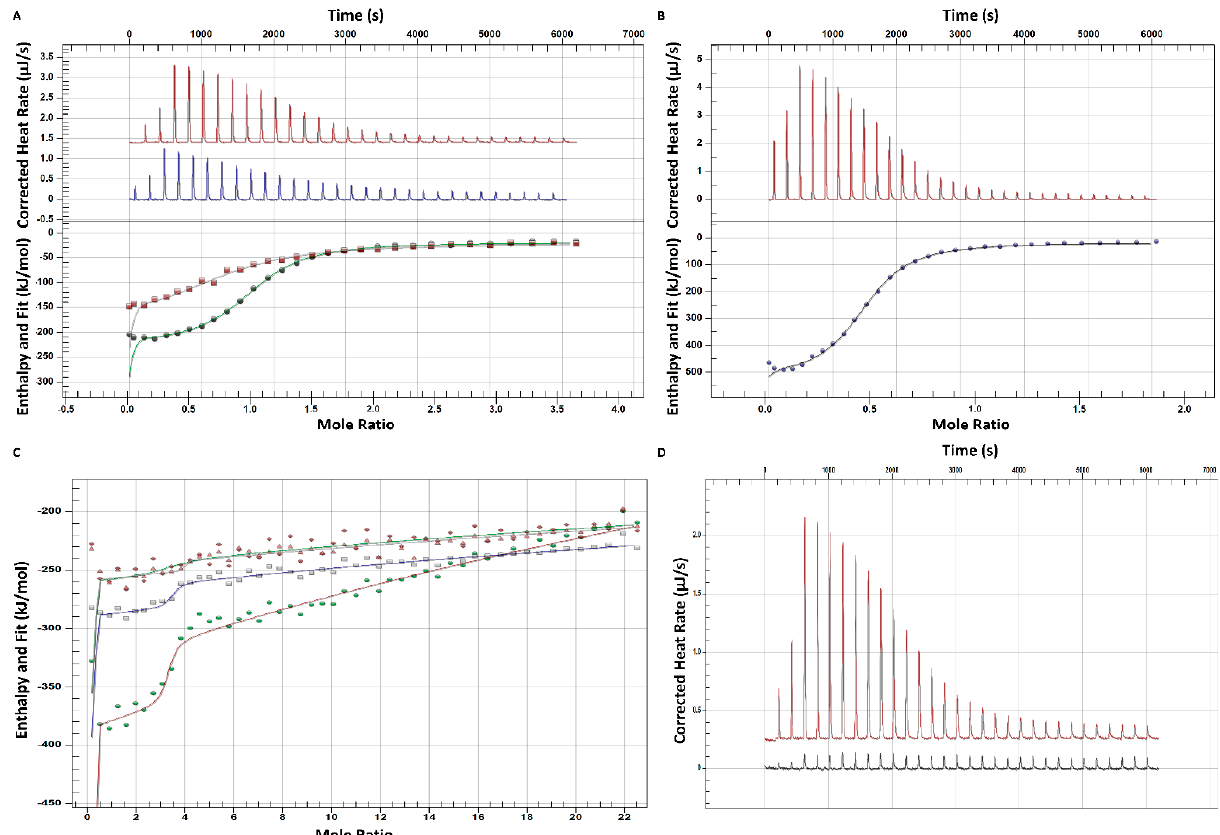
Figure 7. Integrated ITC data for the titration of ( A ) 10 µM A1 against 30 µM miR21 (red) and 10 µM A2 against 30 µM miR21 (blue), ( B ) 10 µM A1 + 10 µM A2 against 30 µM miR21, ( C ) Binding thermodynamic curve for the interaction between 0.97 µM A2@GNRs and 30 µM miR21 (green), 0.97 µM A2@GNRs and 30 µM miR21-sp (gray), 0.97 µM A2@GNRs and 30 µM random (red), ( D ) Corrected heat rate (µJ/s) plotted as a function of time for the ITC experiments studying the interaction between A1 and miR21 (red), A1 and anti-miR21 oligonucleotide (black).